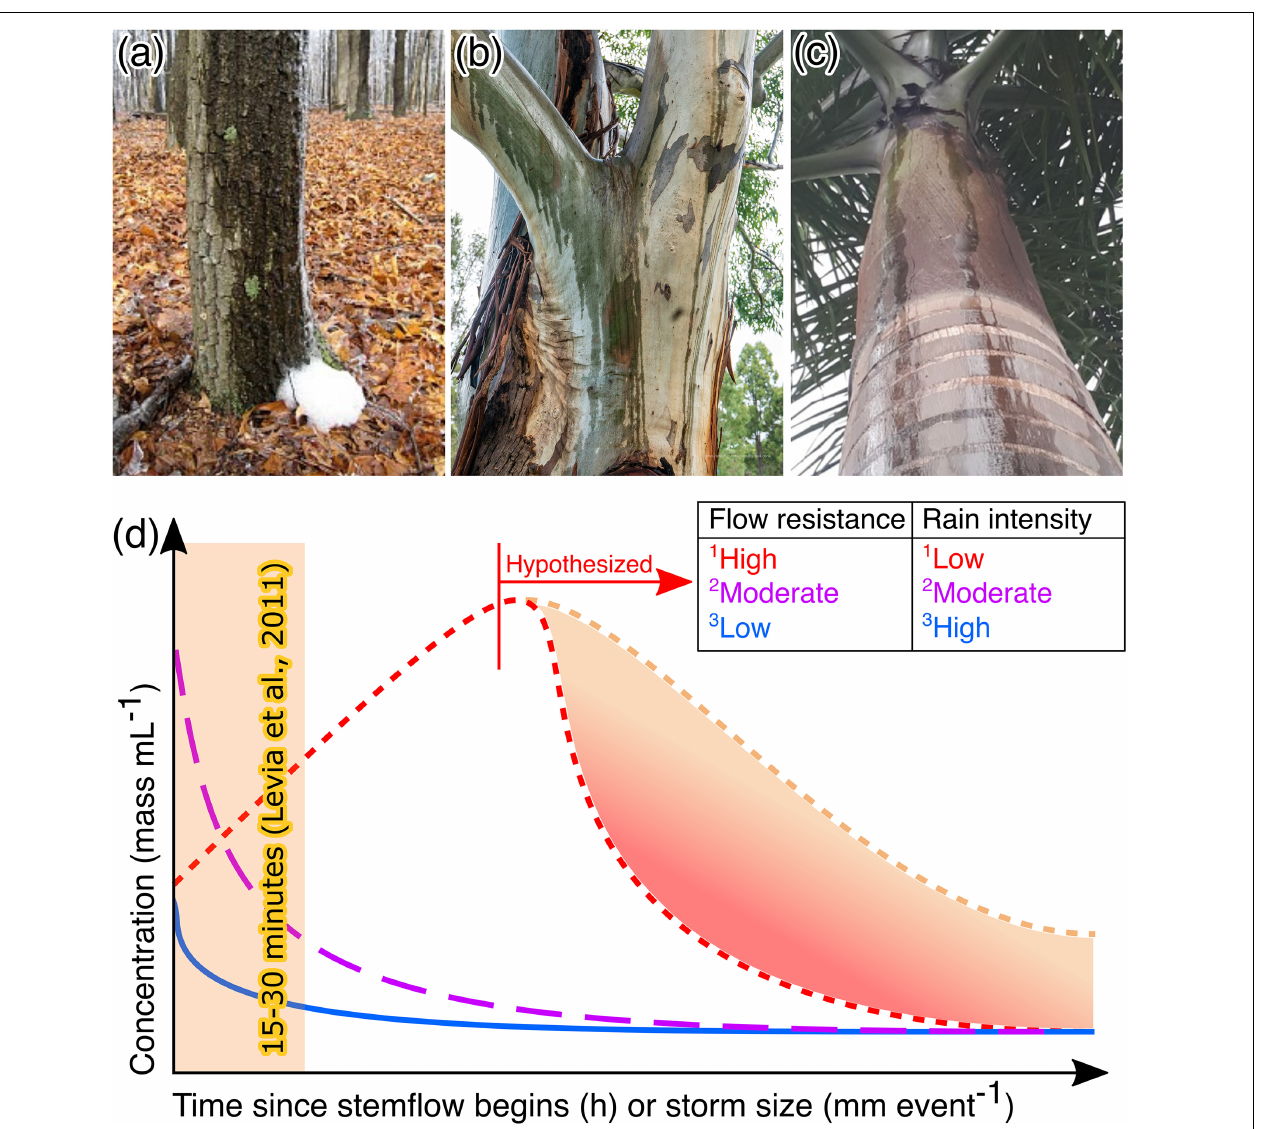
FIGURE 2 | Photographs showing types of stemflow that has been sampled, including (a) the foam that can sometimes accumulate at the base of a stemflow rivulet (West, 2010); (b) major stemflow rivulets (McPherson, 2018); and (c) multiple discrete stemflow rivulets on a single trunk of a palm, Roystonea regia [photograph reproduced from Salemi (2019) with permission]. (d) Conceptual summary of different temporal dynamics previously observed in stemflow solute concentrations from different combinations of tree species and rain intensities. 1 Quercus virginiana hosting a substantial bromeliad-fern-lichen epiphyte assemblage in subtropical maritime forest, Georgia, United States (Van Stan et al., 2017). 2 Liriodendron tulipifera and 3 Fagus grandifolia , both in a temperate, maritime forest, Delaware, United States (Levia et al., 2011). Note that no new data was used to generate this conceptual